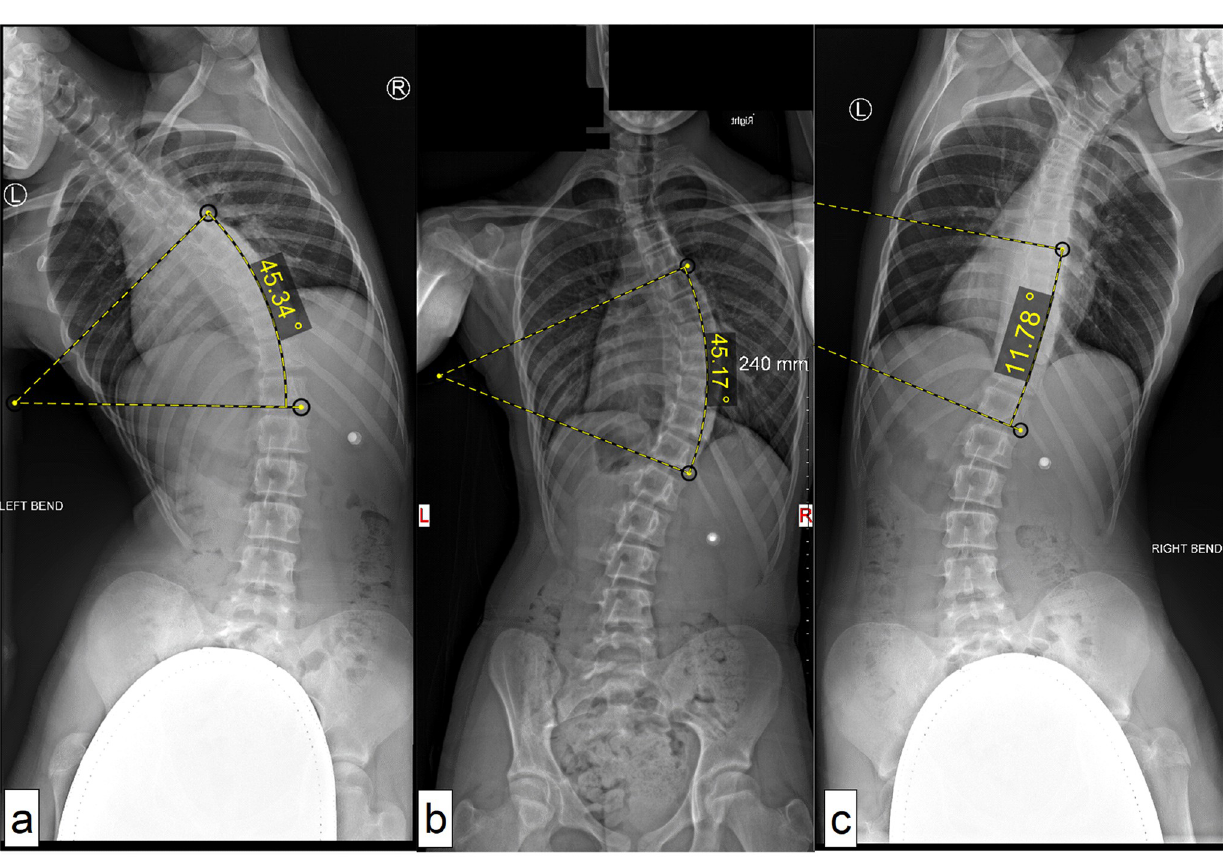
Fig 2. Exemplar flexibility measurement.